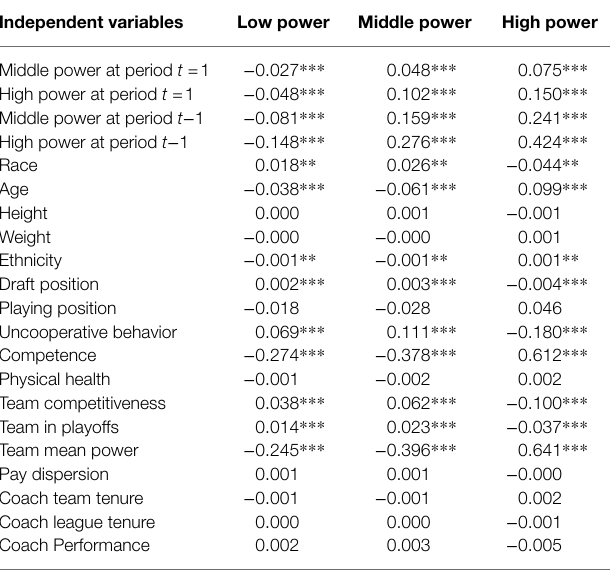
TABLE 5 | Marginal effects of the random effects ordered probit model on the probability of power a . Independent variables